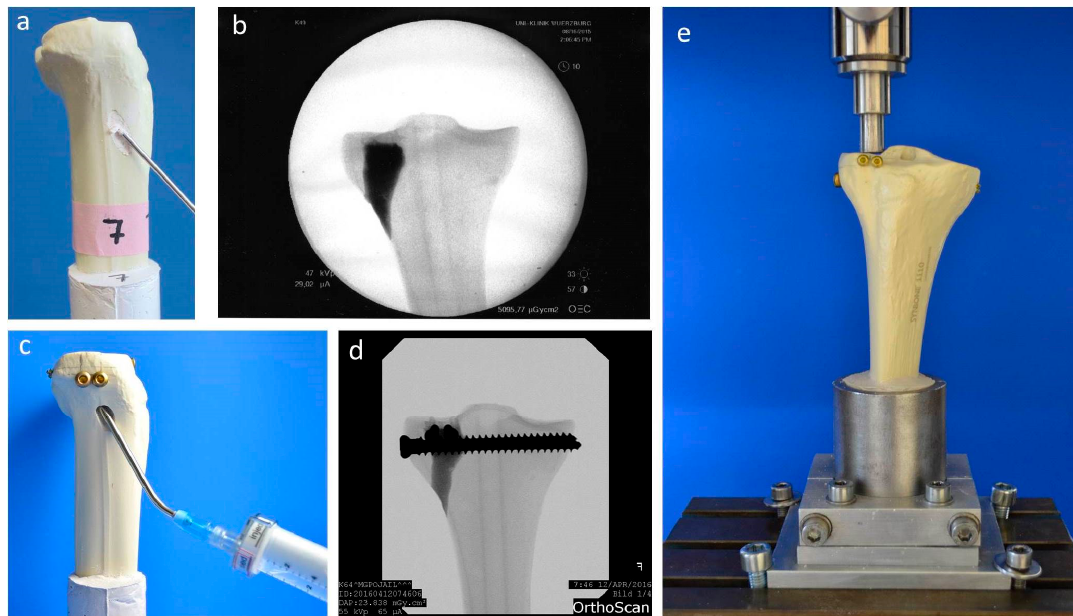
Figure 3. Application of bone cement and test set-up. Visualization of the different test groups: In groups 1–4, the remaining metaphyseal bone defect after fracture reduction was filled up with bone substitute only ( a ). In contrast, in groups 5–7, an additional screw osteosynthesis was set by the jail technique ( c ) and the filling of the defect was done before or after the osteosynthesis, depending on the drillability of the cement. To control the complete filling with cement and the position of the screws, specimens were examined by X-ray ( b , d ) before the biomechanical testing, where an axial load on the fixed fracture was performed ( e ).